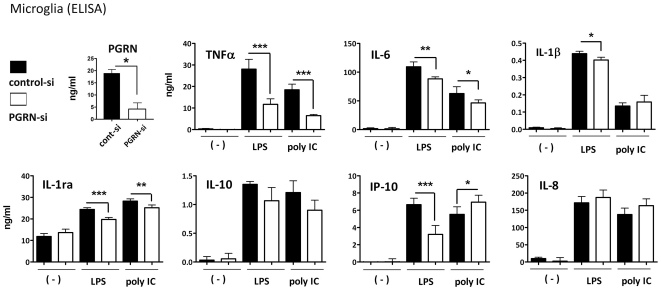
Role of microglial PGRN in TLR3/4-mediated cytokine production.Microglial cultures were treated with siRNA specific for human PGRN (PGRN-si: white symbol) or a control non-targeting siRNA (cont-si: black symbol) for 3 days. Cultures were then stimulated with LPS or poly IC for additional 24 h. (A) PGRN ELISA was performed to determine the effect of PGRN-si in microglia. (B to H) TNFα, IL-6, IL-1β, IL-1ra, IL-10, IP-10 and IL-8 were measured by ELISA in the same culture. Results from a representative experiment are shown. Data are mean ± SD from triplicate samples (* p<0.05, ** p<0.01, ***p<0.001). The results show that PGRN-si reduces the production of multiple cytokines and chemokines induced by LPS or poly IC.